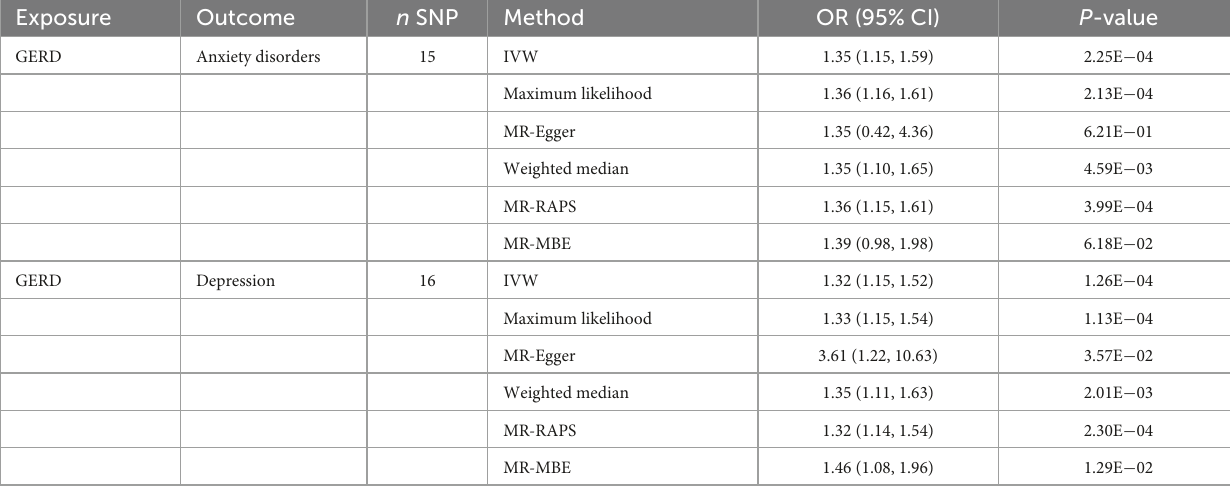
TABLE 3 Mendelian randomization results of the causal effect of GERD on anxiety disorders and depression (based on the IVs screened under the genome-wide significance threshold).